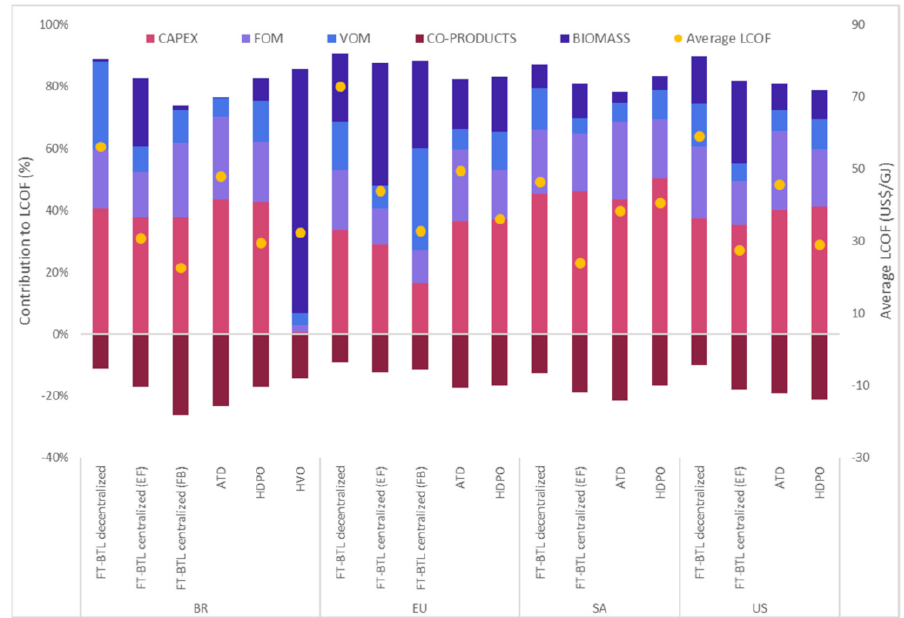
Figure 20. LCOF breakdown for each technology and average LCOF values. Note: SVO is not represented given that its LCOF is its